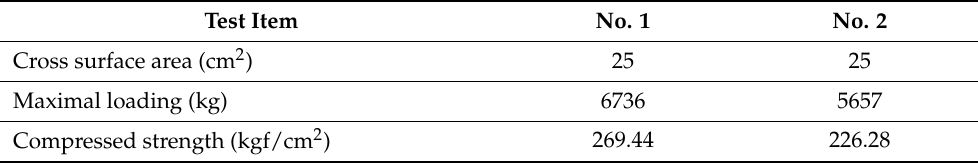
Table 1. Compressive strength of different concrete